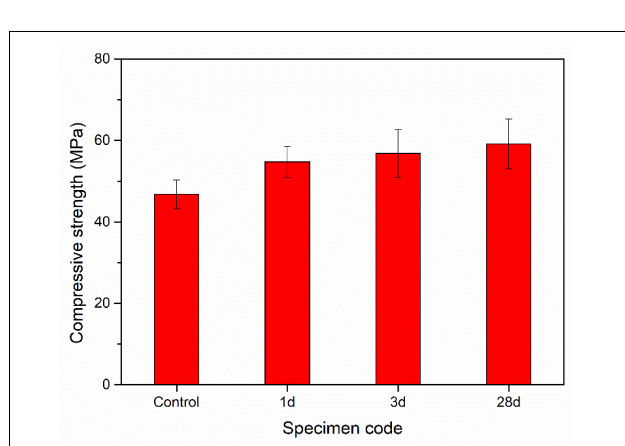
FIGURE 14 | Compressive strength of plain concrete beam and concrete beam repaired with CSA-ECC for different age.